Question: Condense the content of this figure into a single sentence.
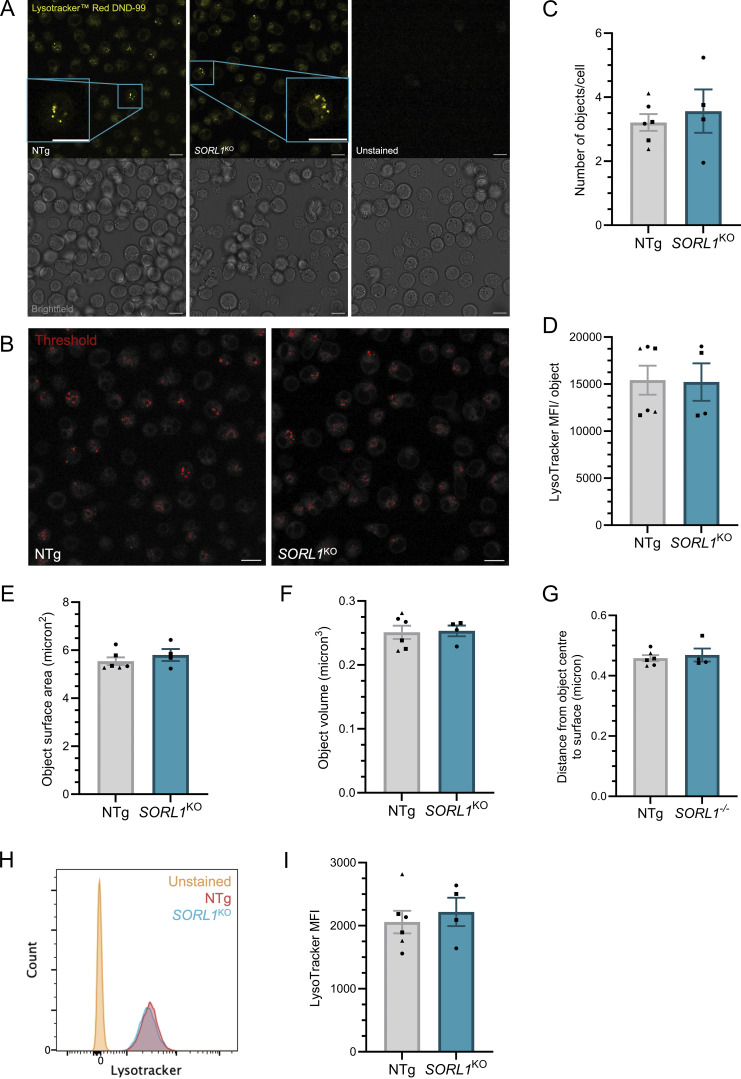
Answer: SorLA does not play a role in lysosome maintenance in Ramos-Cas9 B cells. (A) Confocal micrographs showing NTg and SORL1 KO Ramos-Cas9 B cell lines labelled with LysoTracker Red DND-99 (yellow). NTg (left), SORL 1 KO (center), and unstained cells (right); inset (blue box) shows an enlarged view of an individual cell. 100× magnification; scale bars = 10 μm. Corresponding bright-field micrographs below. (B) 3D objects analysis thresholding of A. 3D objects analysis detected LysoTracker-positive objects 10–280 voxels in size (∼500–1,500 nm diameter). (C) Mean number of LysoTracker-positive objects per cell in NTg and SORL1 KO Ramos-Cas9 cell lines. (D) MFI of LysoTracker-positive objects per cell in NTg and SORL1 KO Ramos-Cas9 cell lines. (E) Mean surface area of LysoTracker-positive objects per cell in NTg and SORL1 KO Ramos-Cas9 cell lines. (F) Mean object volume of LysoTracker-positive objects per cell in NTg and SORL1 KO Ramos-Cas9 cell lines. (G) Mean distance from center to surface of LysoTracker-positive objects per cell in NTg and SORL1 KO Ramos- Cas9 cell lines. (H) Flow cytometry population histograms for unstained (orange), NTg (blue), and SORL1 KO (red) I LysoTracker MFI in NTg and SORL1 KO Ramos-Cas9 cell lines. (I) Quantification of LysoTracker MFI in NTg and SORL1 KO Ramos-Cas9 cell lines. n = 4–6 independent Ramos-Cas9 transductions with three NTg sgRNAs and two SORL1 -targeting sgRNAs (indicated by different symbols). (C–G) n = 4–6, each the mean of ∼100 cells from six images from two independent experiments. Data show mean ± SEM.